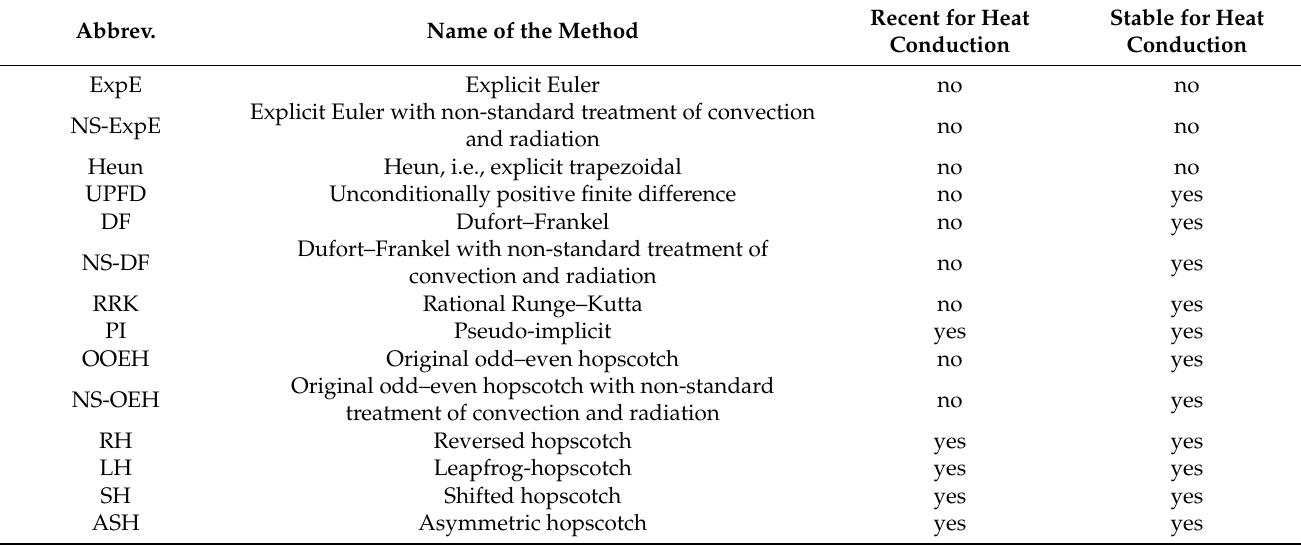
Table 1. List of the methods and their